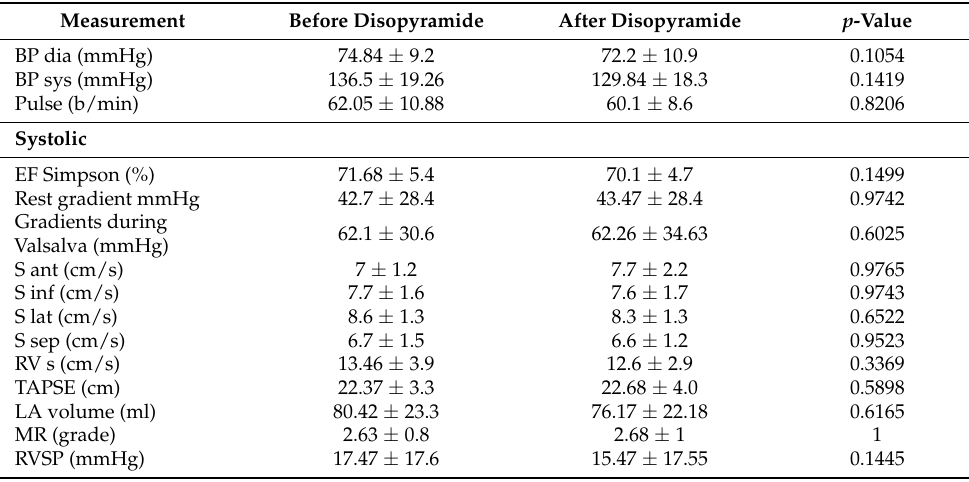
Table 1. Conventional Echocardiography results in 19 patients with HOCM (mean ±